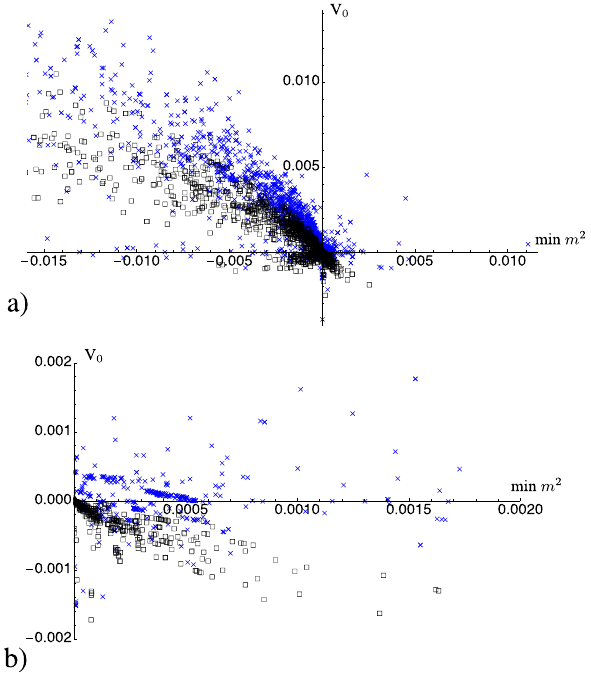
Fig. 2 Plot of the critical points found by the hybrid algorithm. The blacksquarescorrespondtothecaseswhere F 5 contributionsweretaken into account without non-BPS states, whereas the blue crosses consider the presence of ˆ D 5 non-BPS states. On the second image, we present a zoom of the stable